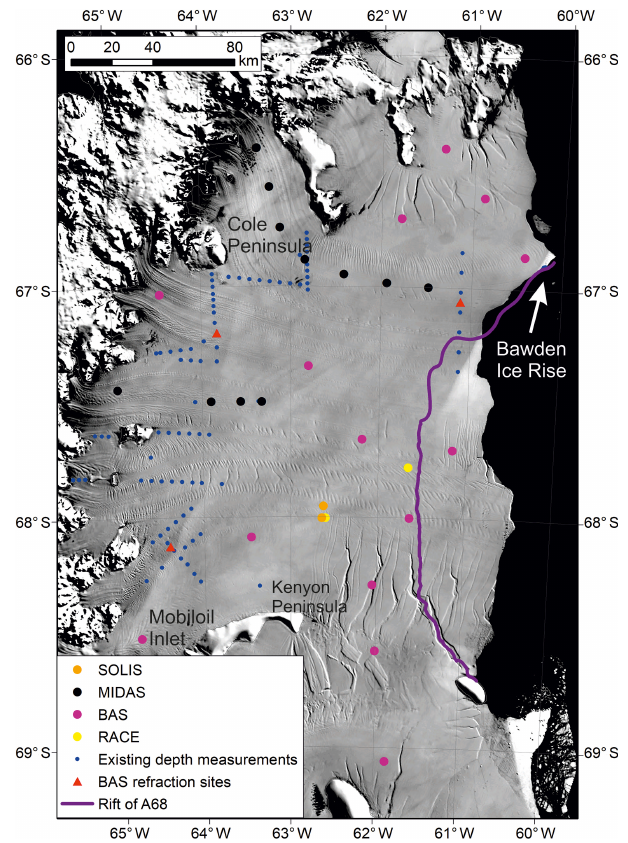
Figure 1. Map of seismic points used in the gridded bathymetry product of this study. The approximate path of the ice shelf rift that resulted in the calving of iceberg A68 is highlighted (Jansen et al., 2015). The background is MODIS imagery (Scambos et al., 2007), predating the break-off of iceberg A68 along the rift.